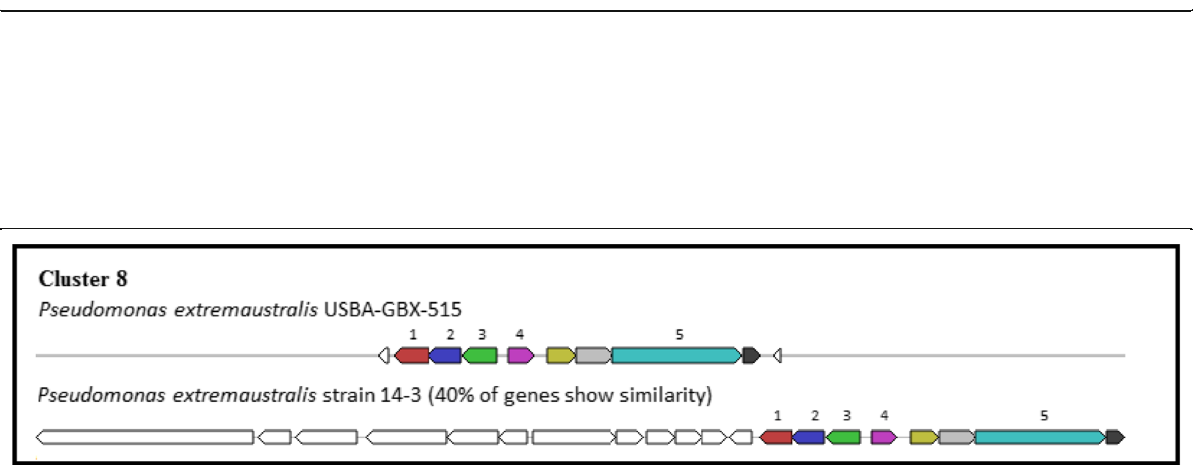
Fig. 10 Genetic map of coronatine biosynthetic gene cluster 7 detected by AntiSMASH 3.0. The genes were designated by colors. Same color means equal genes in different strains; not colored means other genes. 1. hypothetical protein PA4617; 2. quorum-sensing control repressor; 3. Motility regulator; 4. serine hydroxymethyltransferase; 5. hypothetical protein PA4604; 6. threonine transporter RhtB; 7. Thioesterase; 8. non-ribosomal peptide synthetase; 9. coronamic acid synthetase CmaD; 10. hypothetical protein; 11. transcriptional regulator of proline and 4-hydroxyproline utilization HypR; 12.ABC transporter ATP-binding protein